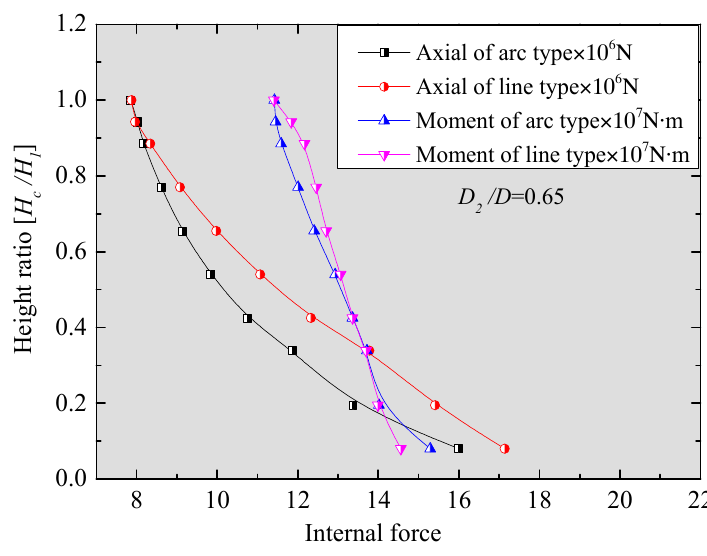
Figure 4. Cross-section of the internal force.